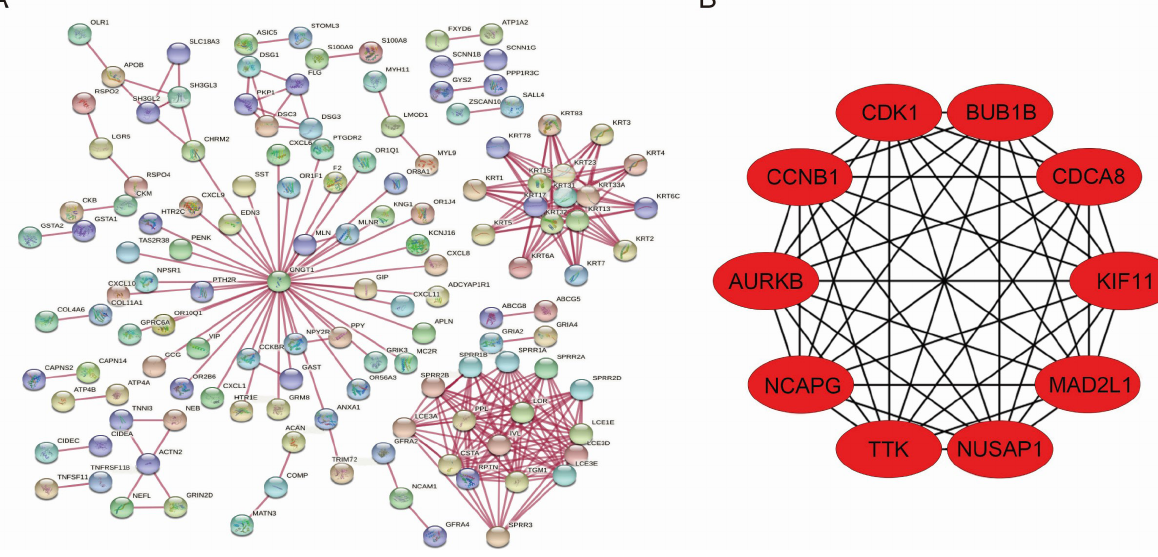
Figure 4. PPI network of differential genes and top 10 core genes in gastric cancer. (A) PPI map of differentially expressed genes in gastric cancer; (B) top 10 core genes in gastric